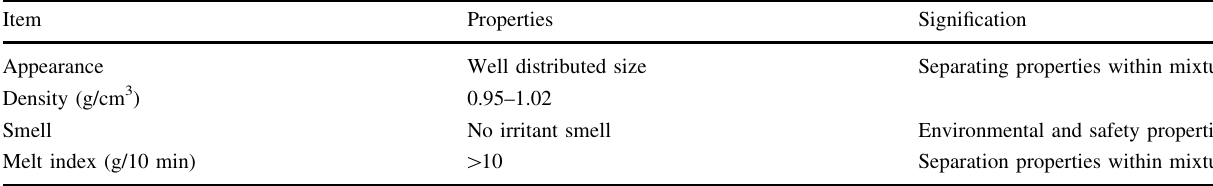
Table 3 Properties of road-science-technology (RST) asphalt modifier Item